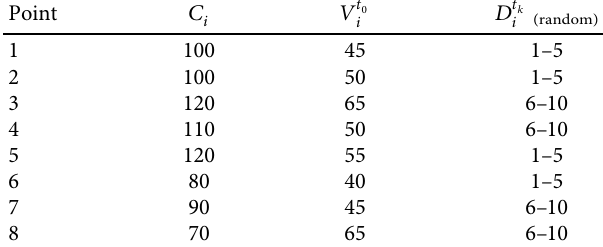
Figure 3: Location of bike-sharing rental points and parking lot. Table 1: Capacity, initial number, and demand of bike-sharing.